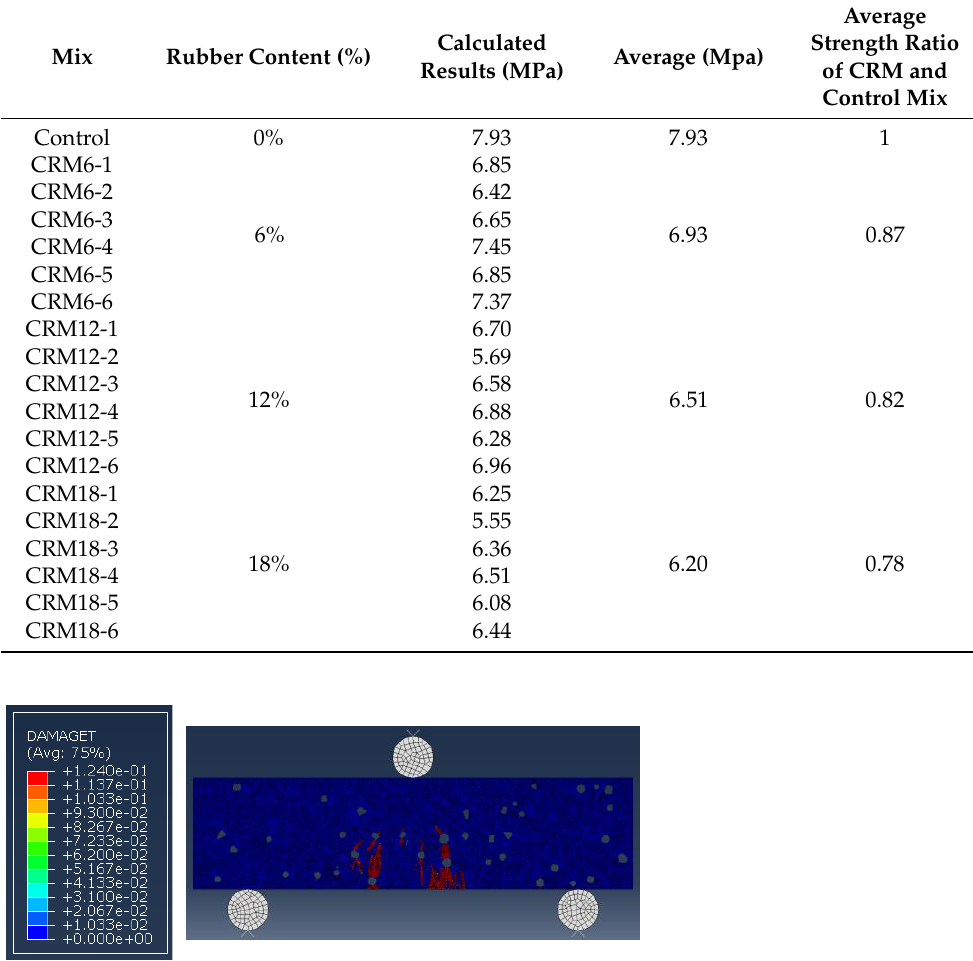
Figure 25. Tensile damage of CRM 12 specimens.